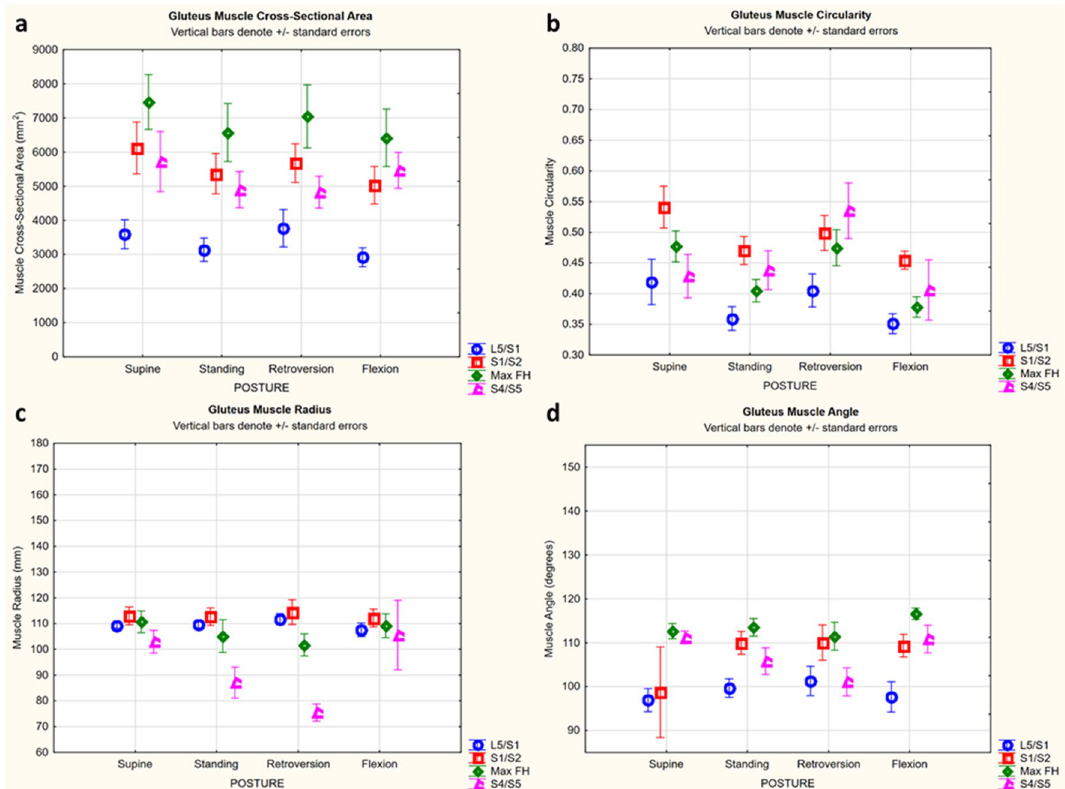
Figure 3. Mean (± SEM) gluteus parameter for each posture shown by level. ( a ) CSA: there was a significant effect and interaction of posture and level (Newman–Keuls significant: supine to standing at max FH, 13% decrease; flexion to retroversion at L5/S1, 22% increase; supine to standing at S4/S5, 16% decrease). ( b ) Circularity: there was a significant effect and interaction of posture and level (Newman–Keuls significant: supine to standing at S1/S2, up to 15% decrease; flexion to retroversion at max FH, up to 20% increase; standing to retroversion at S4/S5, 18% increase; flexion to retroversion at S4/S5, 24% increase). ( c ) Radius: There was a significant effect and interaction of posture and level (Newman–Keuls significant at S4/S5: supine to standing, 18% decrease; supine to retroversion, 36% decrease; standing to retroversion, 15% decrease; flexion to standing, 21% decrease; flexion to retroversion, 40% decrease). ( d ) Angle: there was a significant effect and interaction of posture and level (Newman–Keuls significant: supine to standing, 10% increase at S1/S2; supine to flexion, 10% increase at S1/S2; supine to retroversion, 10% increase at S1/S2; supine to retroversion at S4/S5, 10% decrease; flexion to retroversion at S4/S5, 10%